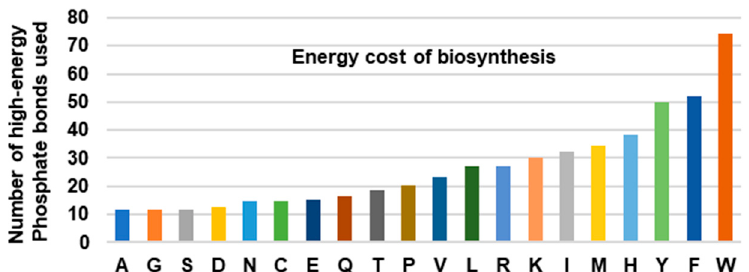
Figure 1. Total energy cost of amino acid biosynthesis. The total number of high-energy phosphates, equivalent to ATP and GTP, required for the biosynthesis of each amino acid, was plotted; the numbers were obtained from [19]. Note that the aromatic amino acids (Tyr, Phe, Trp) are energetically more expensive than the others, Trp being the highest of